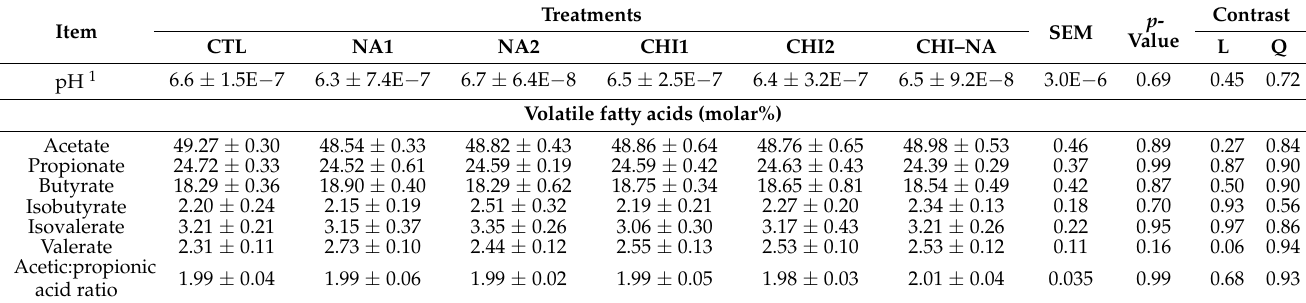
Table 6. Effect of naringin and chitosan supplementation on rumen fermentation parameter in